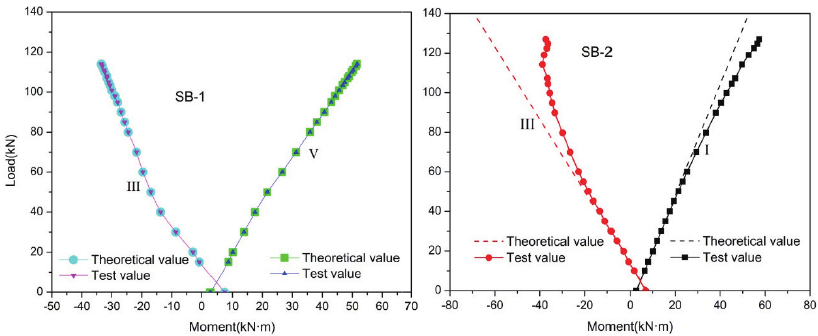
Figure 5. Load–moment